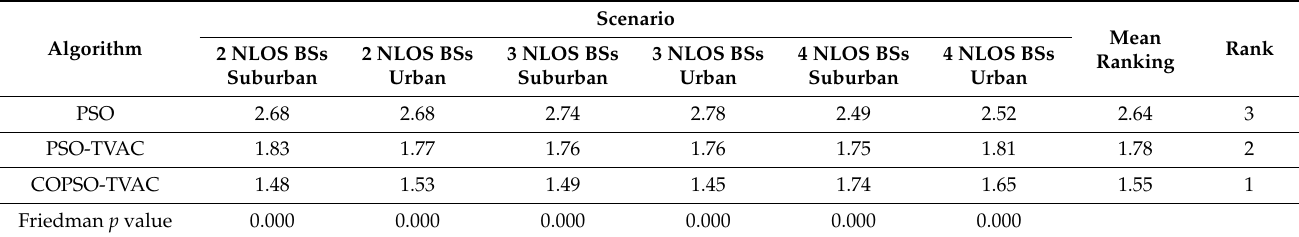
Figure 4. RMSE [m] in the function of the number of the NLOS BSs: the urban environment. Table 4. Average ranks computed through the Friedman test for the proposed metaheuristic algo- rithms across different NLOS scenarios, at the significance level of